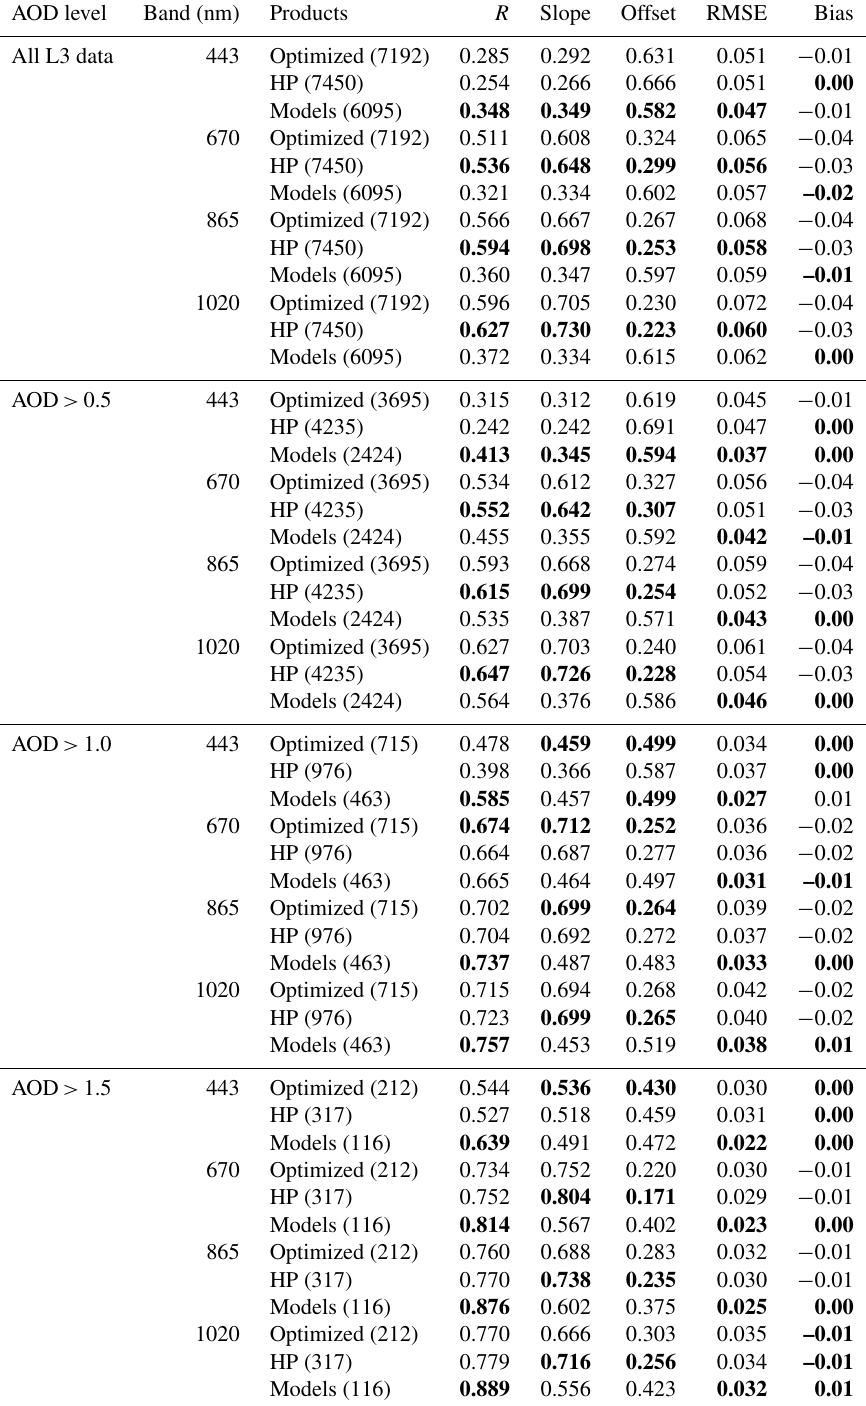
Table 7. Global statistics of PARASOL/GRASP spectral SSA vs. AERONET SSA stratified by PARASOL AOD (565nm) levels. The best performing at each wavelength of three approaches by each metric is labeled in